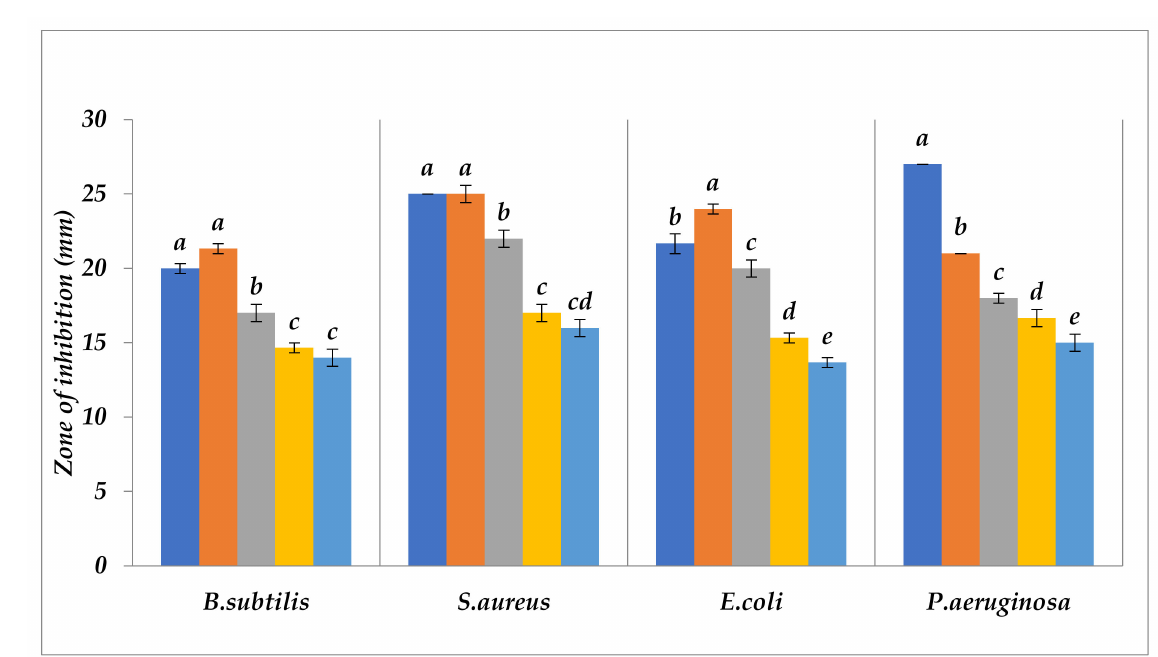
Figure 9. Antibacterial activity of cobalt oxide nanoparticles (Naf) synthesized from fungus Fusarium moniliforme against pathogenic strains at different concentrations as shown in Figure 8. Different letters are indicating significant differences ( p < 0.05) among